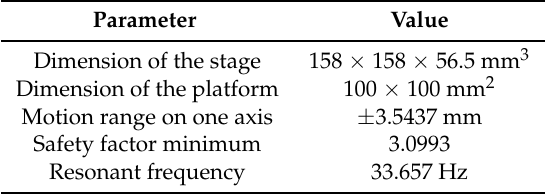
Table 2. Simulation result of performance for the xy